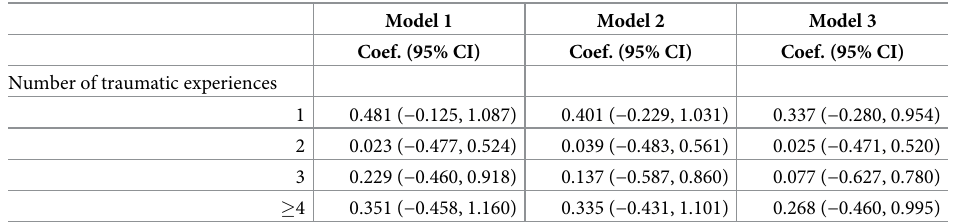
Table 3. Association between the number of traumatic experiences and delay discounting (N =